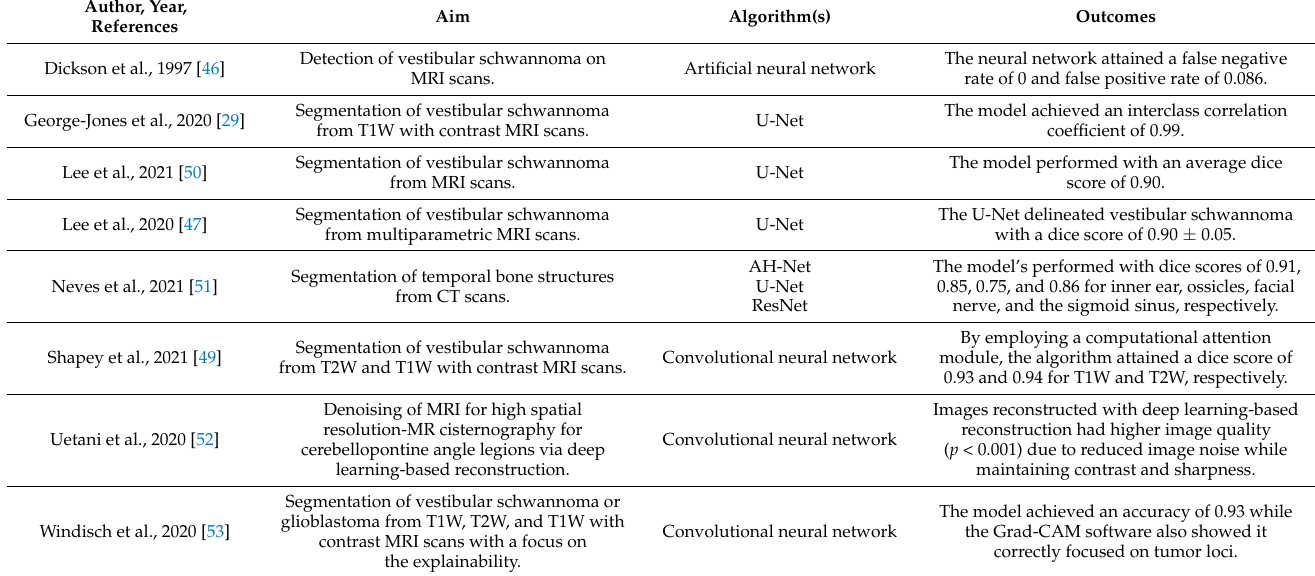
Table 3. Summary of the manuscripts with machine learning applications for MRI/CT tumor